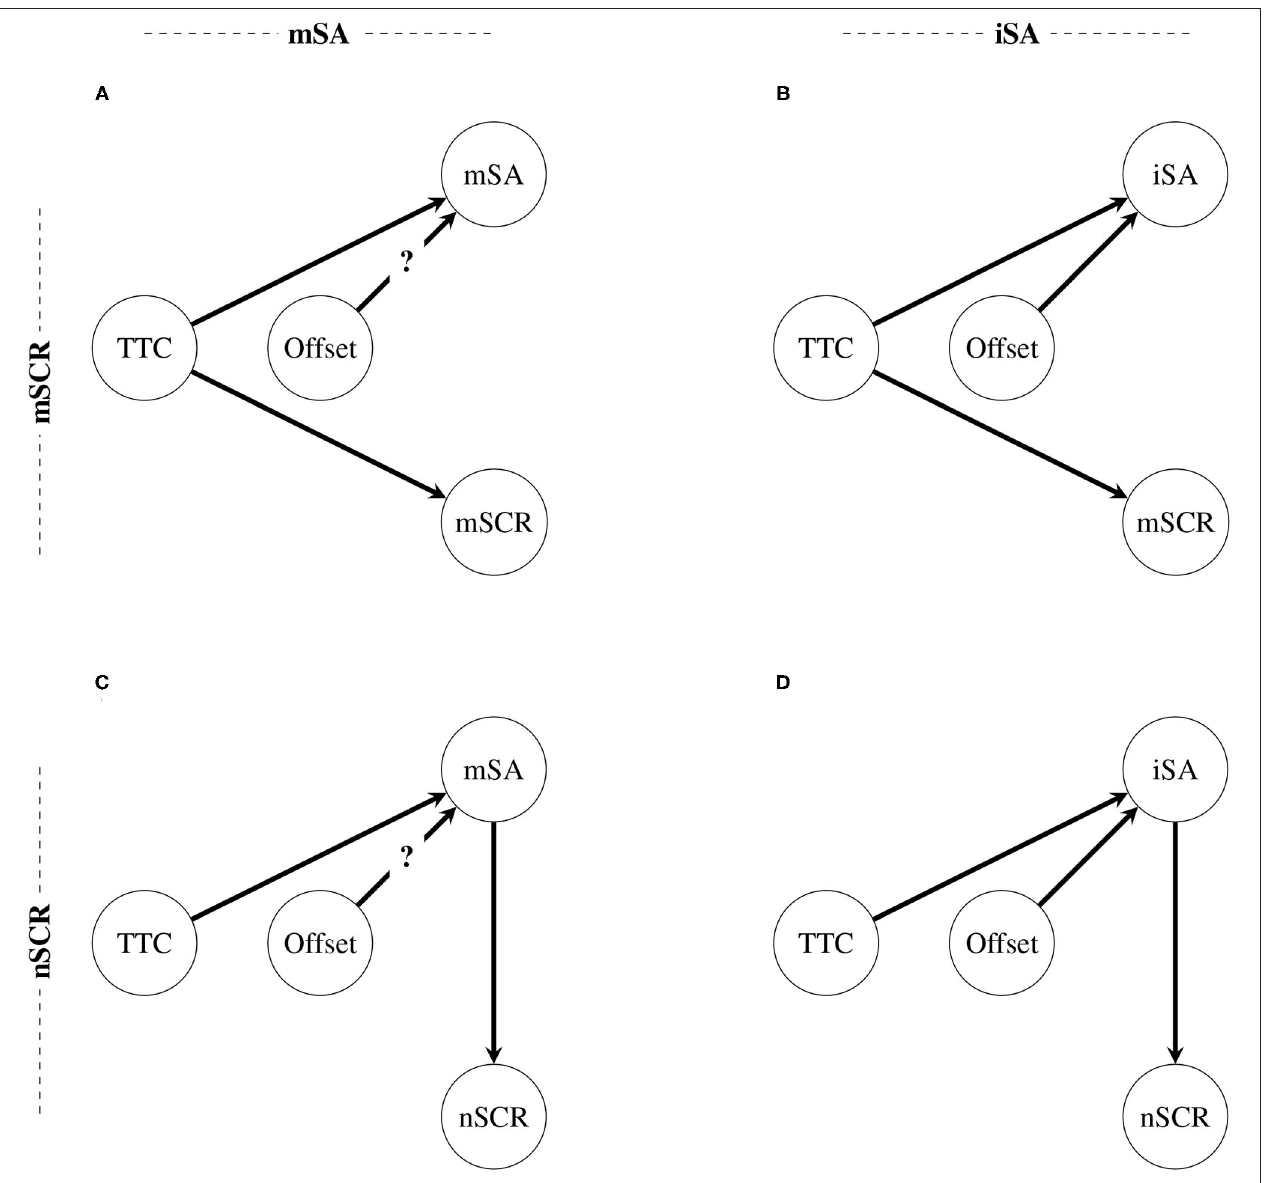
FIGURE 6 | Directed acyclic graphs of the best Bayesian networks by indicators combination. (A) The relationships between the factors and the indicators mSA and mSCR . (B) The relationships between the factors and the indicators iSA and mSCR . (C) The relationships between the factors and the indicators mSA and nSCR . (D) The relationships between the factors and the indicators iSA and nSCR . A question mark was introduced to the illustration of relationship between node Offset and node mSA because the degree of evidence for this relationship is not sufficient regarding the BIC given the thresholds developed by Raftery (1995), which were adopted in this